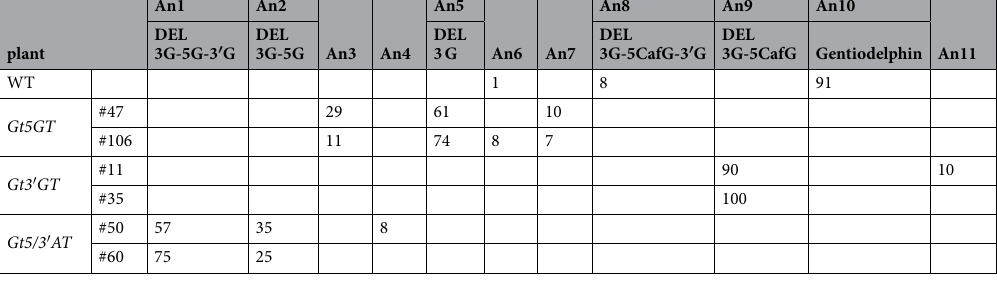
Table 2. Anthocyanin-content ratio calculated from peak area of HPLC at 520 nm